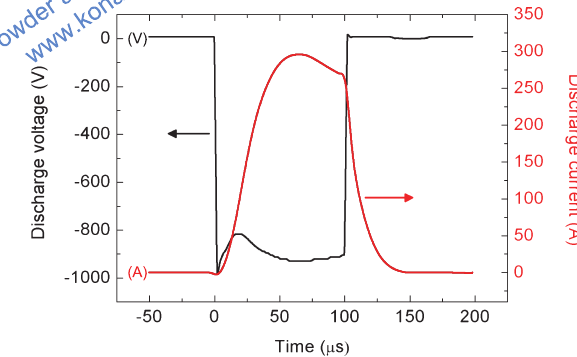
Fig. 1 A typical discharge voltage-current plot in a HiPIMS discharge. This discharge was generated using a 6” cir- cular magnetron equipped with a Cu target operated at 1.33 Pa Ar pressure. The peak current density is about 1.6 A cm –2 and the peak power density is approxi- mately 1.5 kW cm –2 averaged over the entire cathode area. The time-averaged power density is 5.5 W cm –2 .